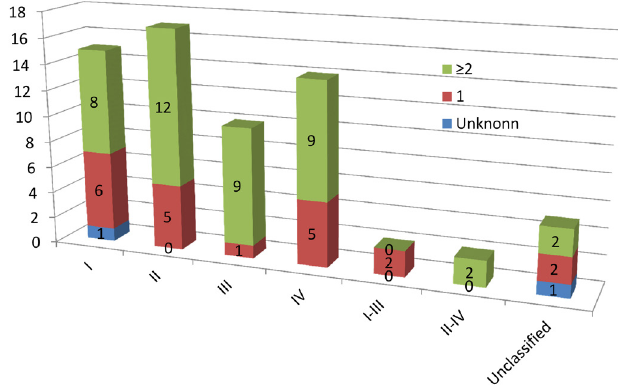
FIGURE 2. The number of different crystal structures distributed in the four classes of the BCS for the 65 APIs that are available as a solid formulation at the